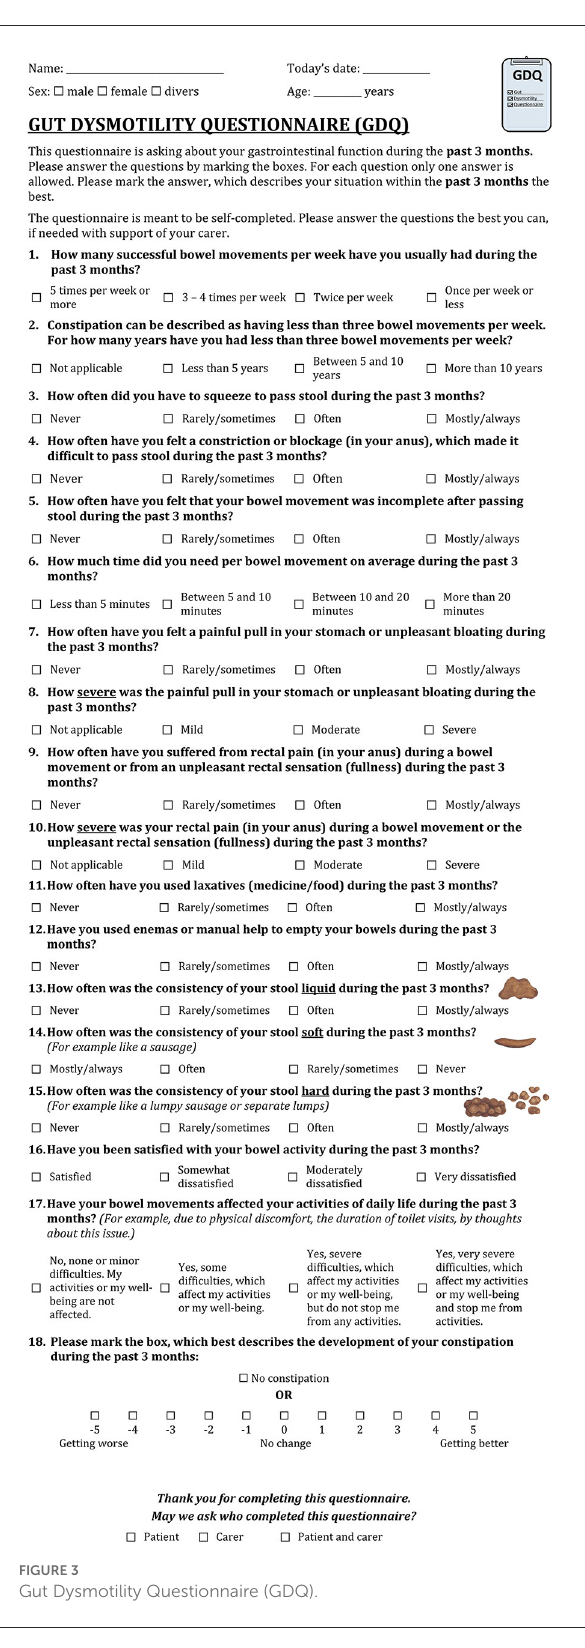
FIGURE3 Gut Dysmotility Questionnaire (GDQ).